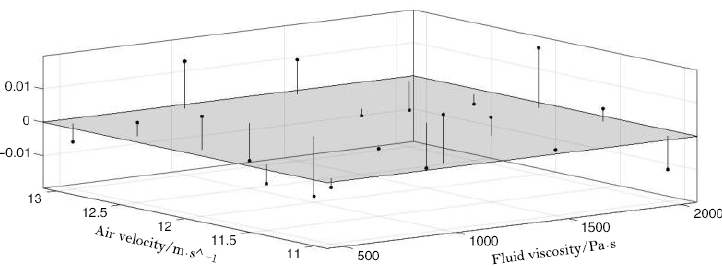
and surface wave height. cosity